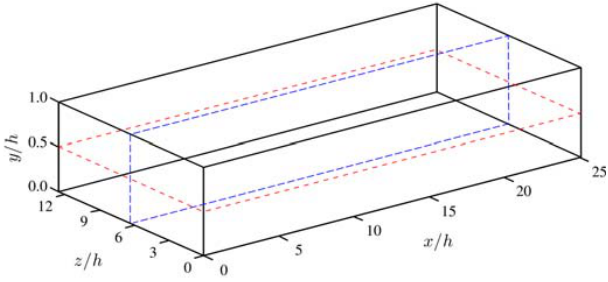
Figure 2. Illustration of the computational domain, where x , y , and z are streamwise, vertical, and spanwise directions, respectively. The red short-dashed and blue long-dashed lines define a horizontal ( x – z ) plane and a spanwise ( x – y ) plane,